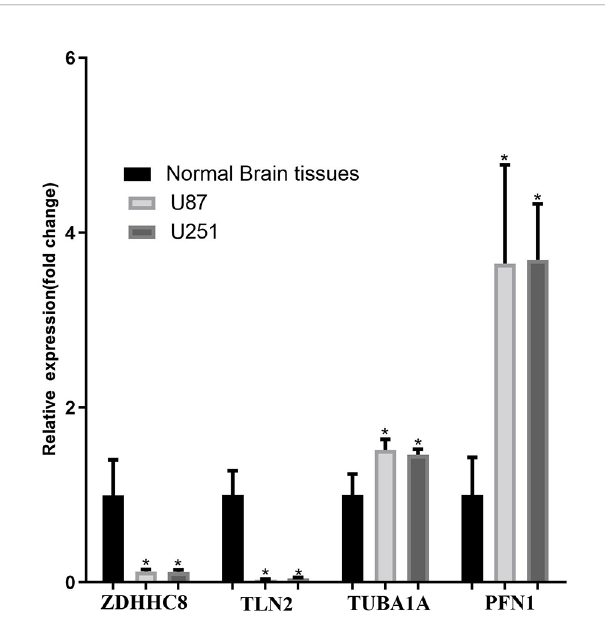
FIGURE 6 | mRNA expression validation in U87 and U251 cells. ZDHHC8, TLN2, TUBA1A, PFN1 expression in U87 cells, U251 cells and normal brain. *p <